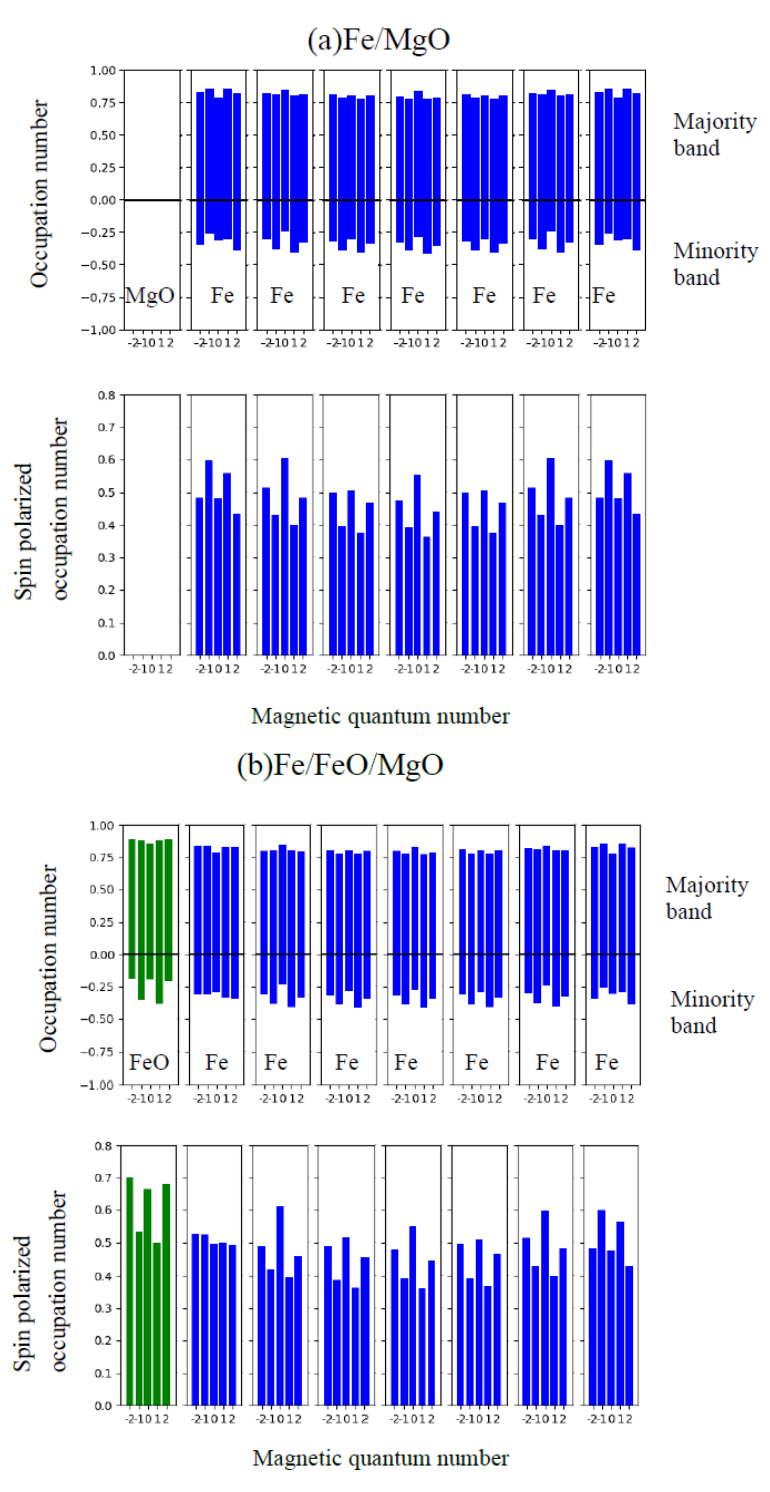
Figure 7. Occupation number and spin-polarized occupation number of magnetic quantum numbers for ( a ) Fe/MgO and ( b ) Fe/FeO/MgO obtained by band structure calculations.